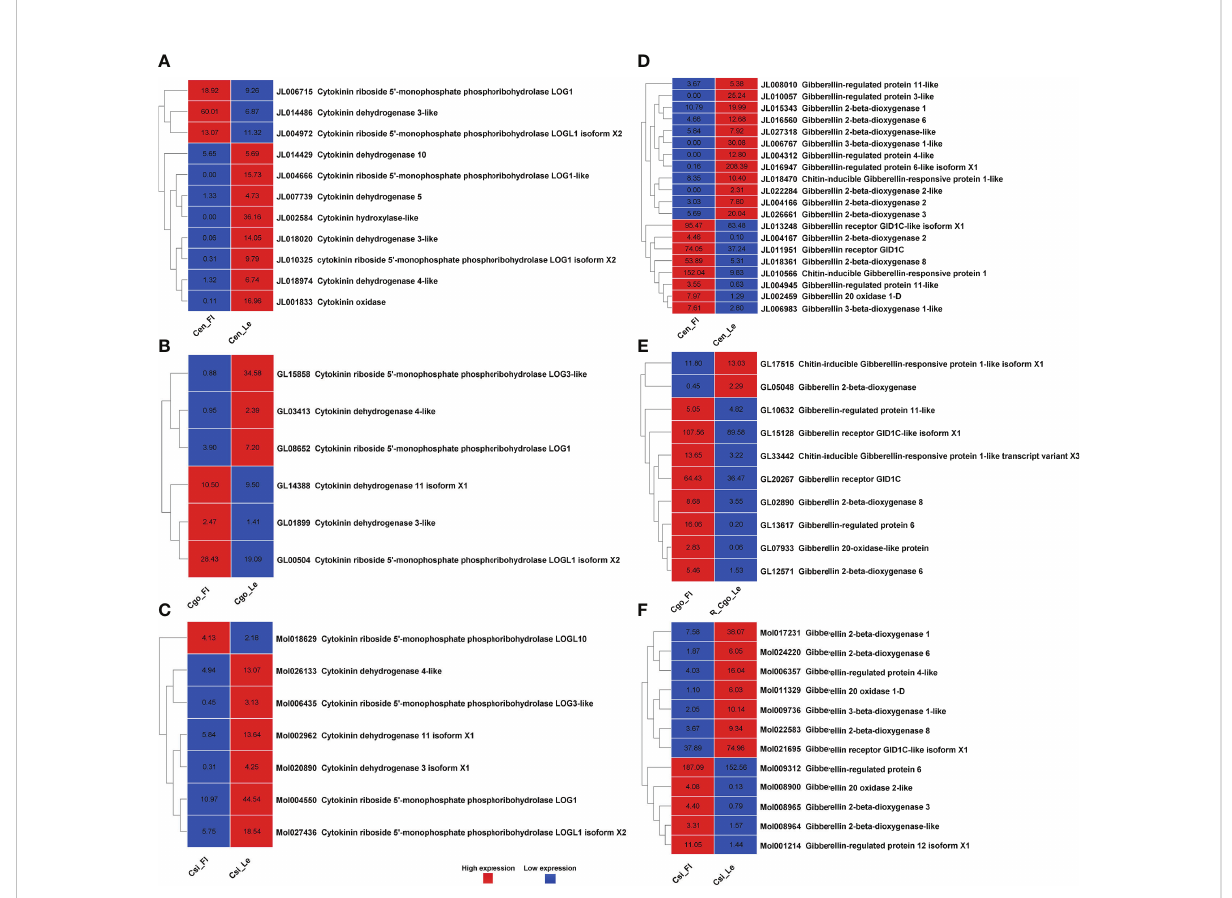
FIGURE 3 Cytokinin pathway genes for C. ensifolium (A) , C. goeringii (B) and C. sinense (C) ; and gibberellin pathway genes for C. ensifolium (D) , C. goeringii (E) and C. sinense (F)